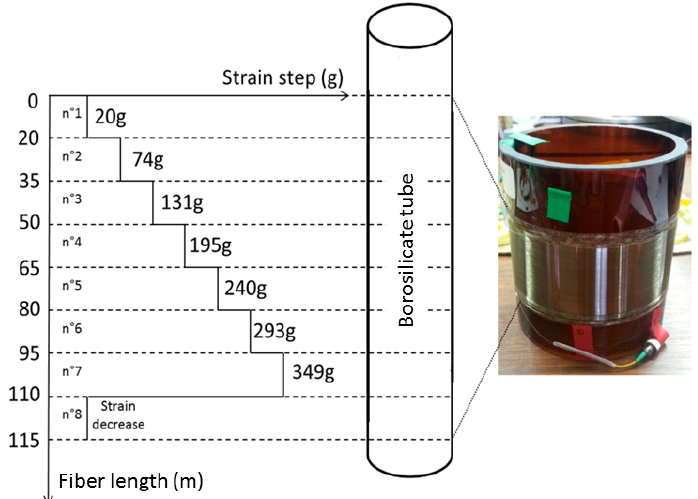
Figure 1. Schematic representation of the fiber coiling distribution with its associated strain steps. The Borosilicate holder darkened during the irradiation run.